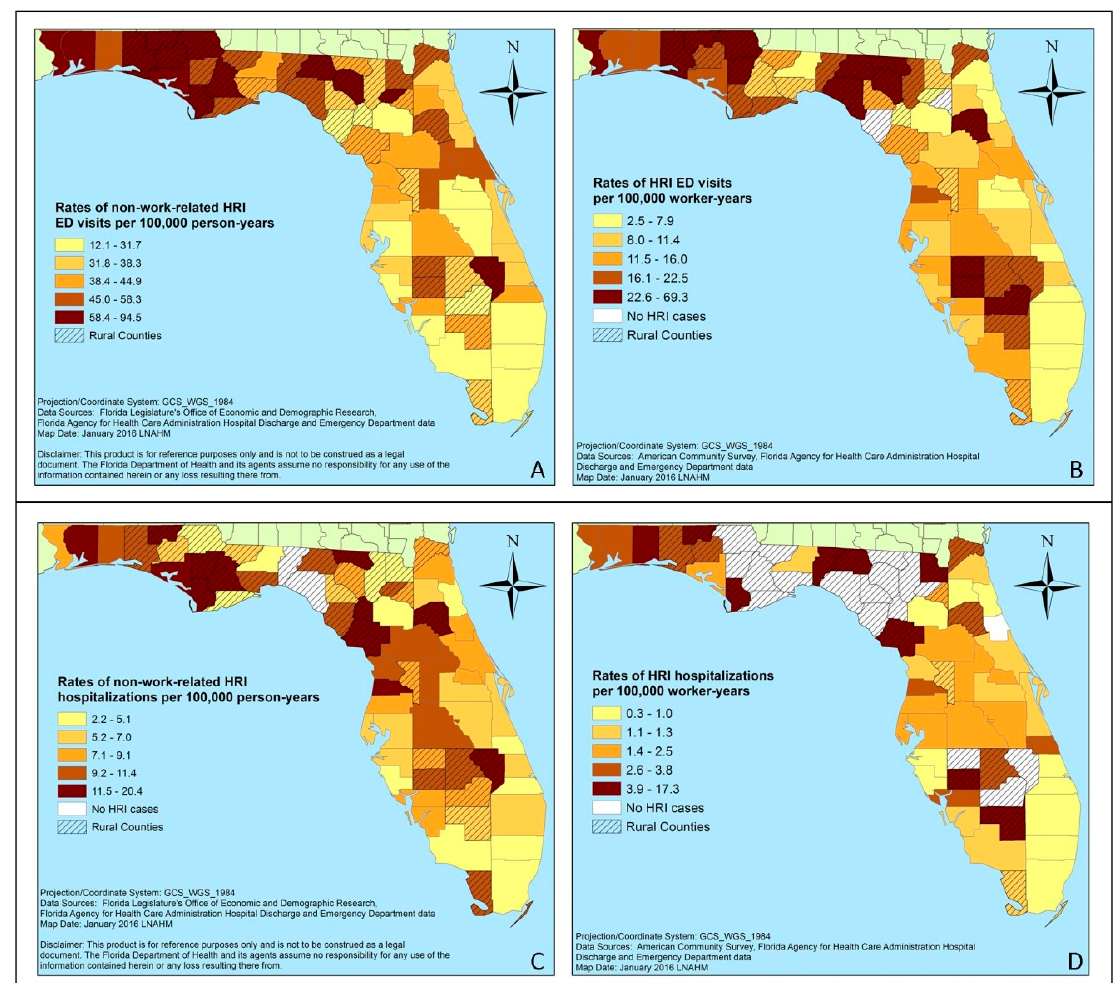
Figure 3. County-specific rates of HRI ED visits and hospitalizations among Florida residents during the warm season (2005–2012): ( A ) non-work-related HRI ED visits rates per 100,000 person-years; ( B ) work-related HRI ED visits rates per 100,000 worker-years; ( C ) non-work-related HRI hospitalizations rates per 100,000 person-years; ( D ) work-related HRI hospitalizations rates per 100,000 worker-years.